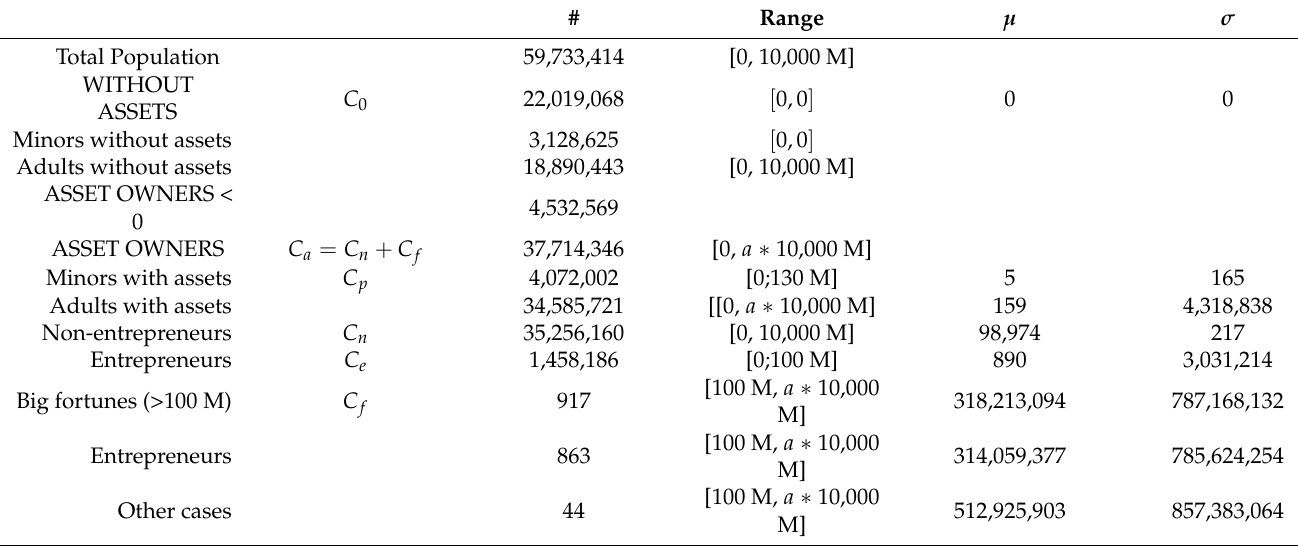
Table 5. Parameters of the subpopulation